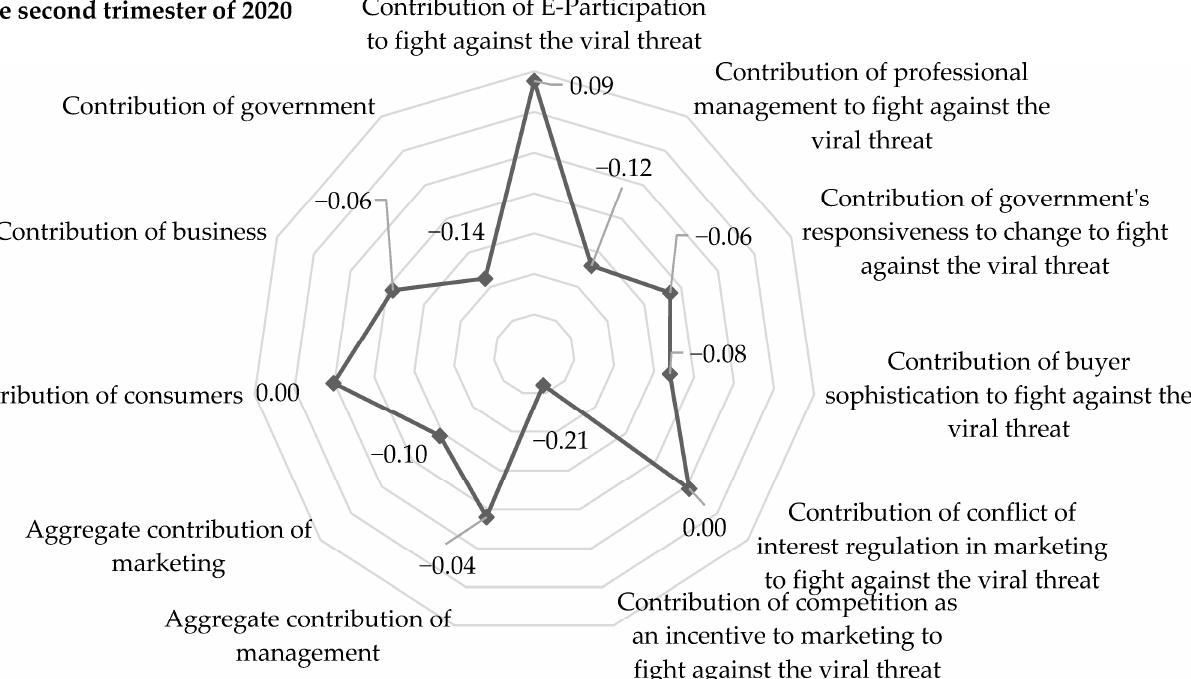
Figure 2. Contribution of management and marketing factors to the pandemic risk management in the third trimester of 2020. Source: Calculated and developed by the authors according to the dataset (Sozinova 2022).